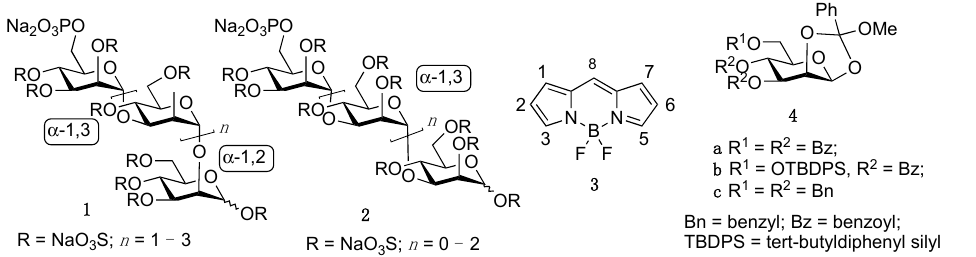
Figure 1. PI-88 ( 1 , 2 ), BODIPY ( 3 ), IUPAC numbering) and 1,2-methyl orthoester glycosyl donors ( 4 ) used in this study.